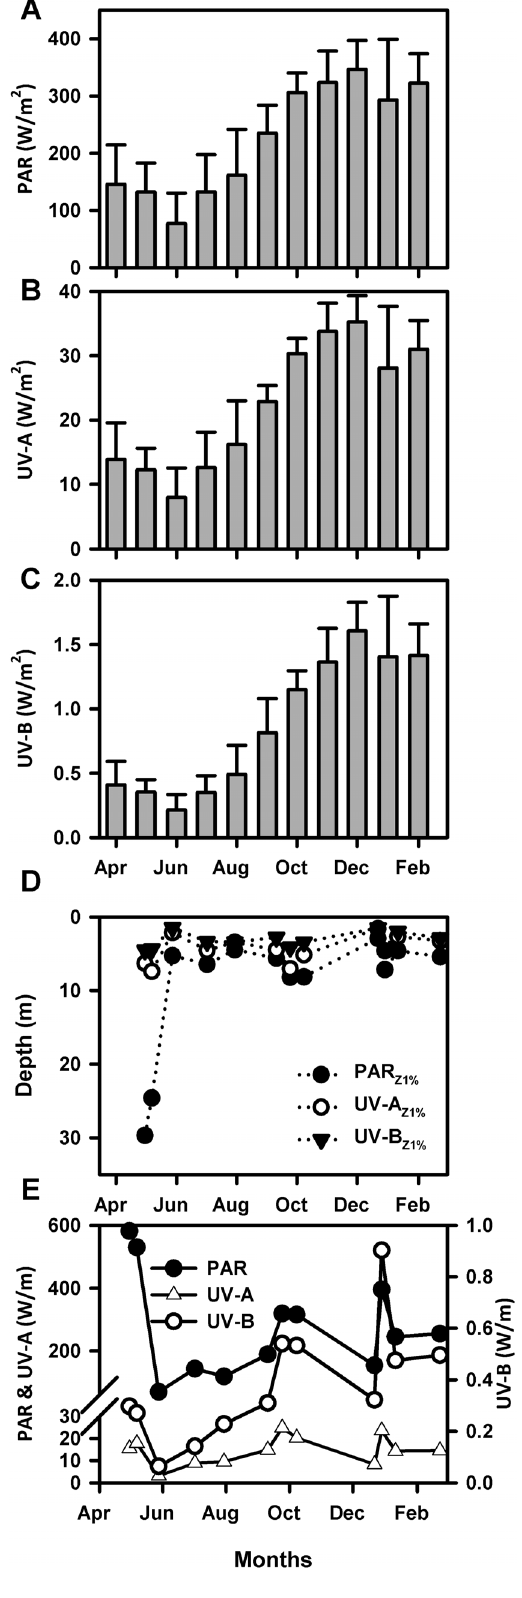
Figure 2. Solar Radiation Time Series. A) Time Series of average values of incident solar radiation for PAR (n=7), B) UV-A (n=7) and C) UV-B (n=7) measured at noon in central Chile (April and